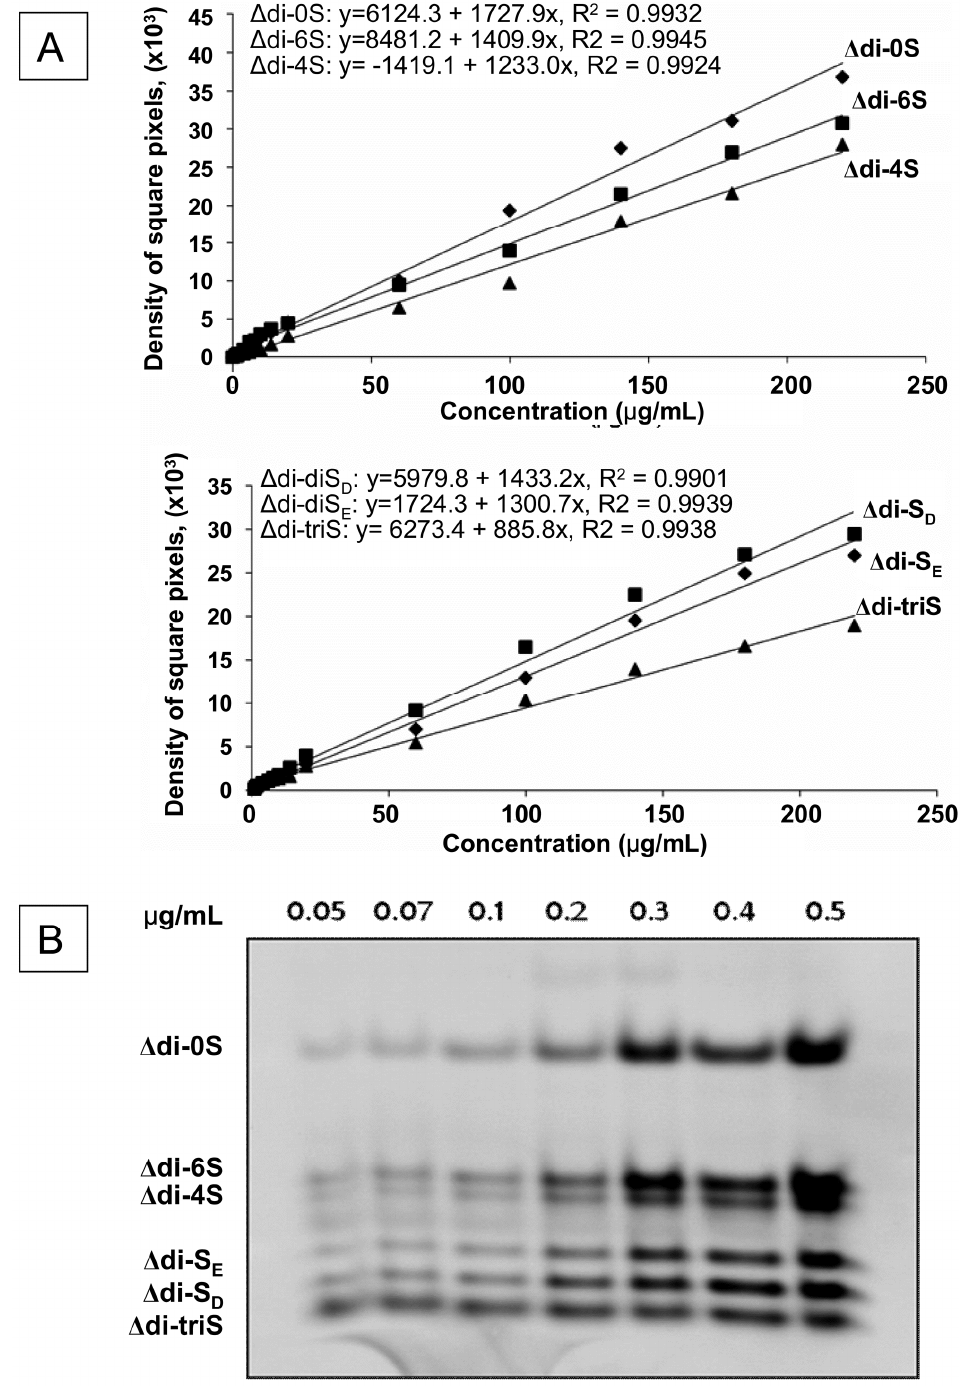
Figure 2. Linearity and sensitivity of FACE analysis. Panel A : Standard curves for Δ di-0S, , Δ di-S and Δ di-triS CS disaccharides at the concentration levels Δ di-6S, Δ di-4S, Δ di-S D E 1.0–220.0 μ g/mL obtained following derivatization with AMAC and FACE analysis. The linearity of Δ -dissacharides values was approved with R 2 > 0.99. Panel B: Analysis of mix of standard AMAC-derived disaccharides by FACE with amounts that vary from 0.05 μ